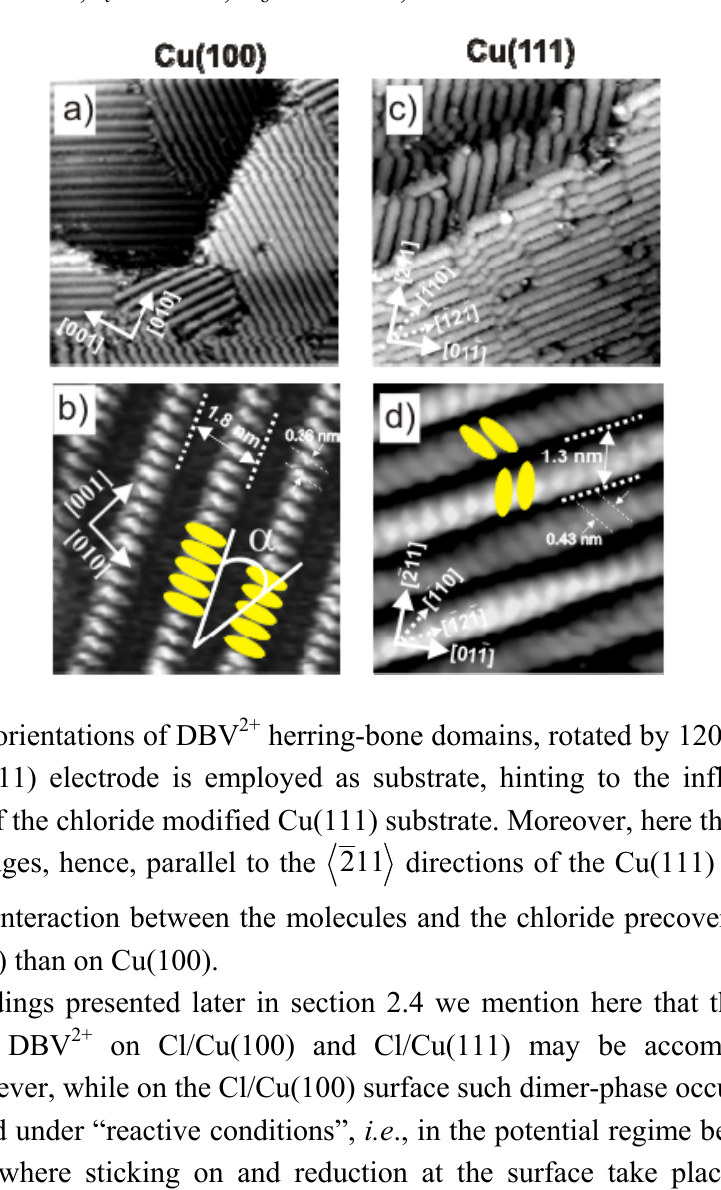
(Figure 3a). For symmetry reasons, there are four orientations of rotational domains in total on the whole Cu(100) surface. Figure 5. Surface morphologies and molecular arrangements on c (2 × 2) − Cl /Cu(100)